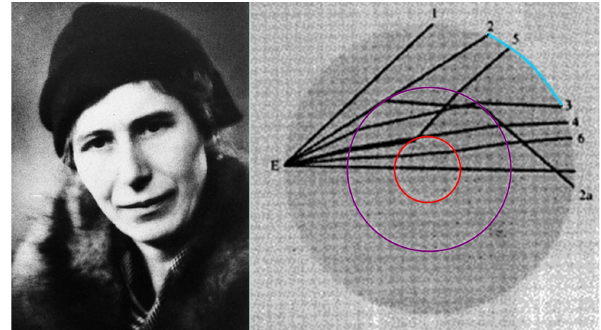
Figure 1. Photograph of Inge Lehmann beside a scan of her origi- nal diagram showing discovery of the Earth’s inner core (Lehmann, 1936). For improved clarity, the circles representing the inner core and the fluid core have subsequently been traced over in red and purple, respectively. The shadow zone, not specifically marked on her original diagram, is indicated in blue. Note the reflection of ray #5 into the shadow